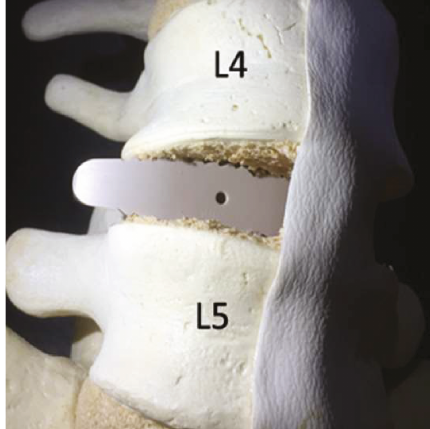
Figure 3: Model picture showed the possibility that MIS-OLIF PEEK cage locked with the vertebral endplates.